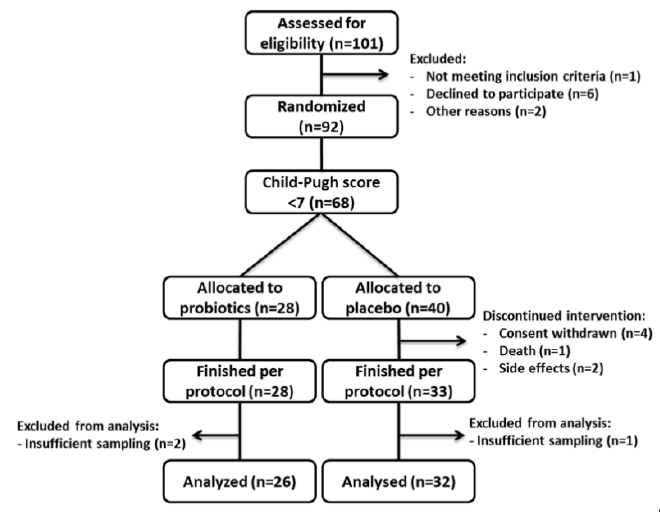
Figure 1. Enrolment Figure 1 . Enrolment scheme.